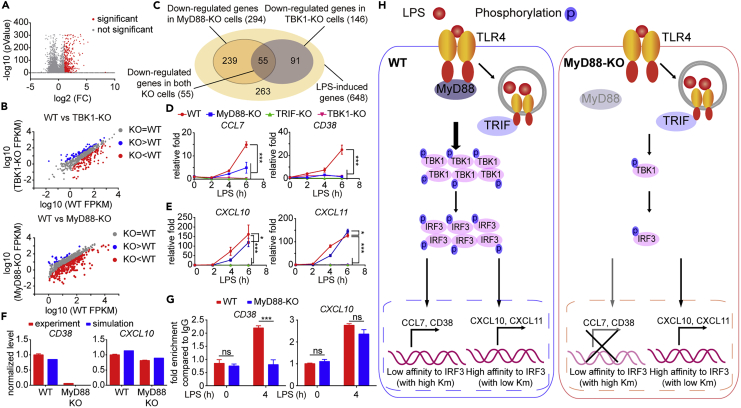
MyD88-TBK1 Axis Controls the Specificity of ISGs Transcription under LPS Stimulation(A) The up-regulated genes under LPS stimulation were marked with red points. The expression with at least two-fold changes and p < 0.05 was chosen (LPS treated versus untreated).(B) Pairwise comparison of FPKM of LPS-induced genes in wild-type (WT), MyD88-knockout (KO), and TBK1-KO THP-1-derived macrophages. Red points indicated that genes expression was two-fold down-regulated in KO cells, whereas blue points marked the up-regulated genes, among which p < 0.05.(C) Schematic of consistently down-regulated genes between MyD88-KO and TBK1-KO THP-1-derived macrophages.(D) Gene ontology analysis for down-regulated genes in both MyD88-KO and TBK1-KO cells.(E and F) quantitative real-time PCR (qRT-PCR) analysis of indicated genes in WT and other indicated KO THP-1-derived macrophages was performed under LPS stimulation for 6 h.(G) ChIP-qPCR assay for IRF3 at CD38 or CXCL10 gene promotor region in WT and MyD88-KO THP-1-derived macrophages stimulated with LPS for 4 h or left untreated.(H) Comparison of induction of CD38 and CXCL10 between experimental data and simulation data under LPS stimulation for 4 h. Proposed model illustrating how MyD88-induced TBK1 activation controls the induction of genes, like CCL7 and CD38 (H).Data in (E)–(G) are plotted as mean ± SEM of three independent biological experiments. ns, not significant (p > 0.05); * p < 0.05, ***p < 0.001.See also Figure S5.